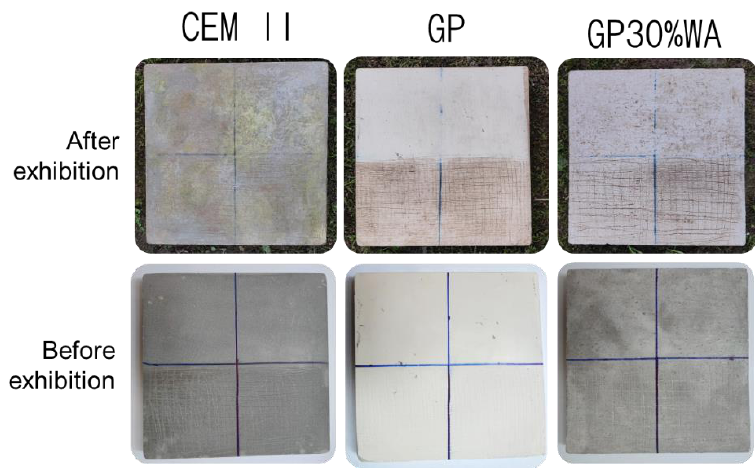
Figure 9. Moss growing test results before and after the exhibition.